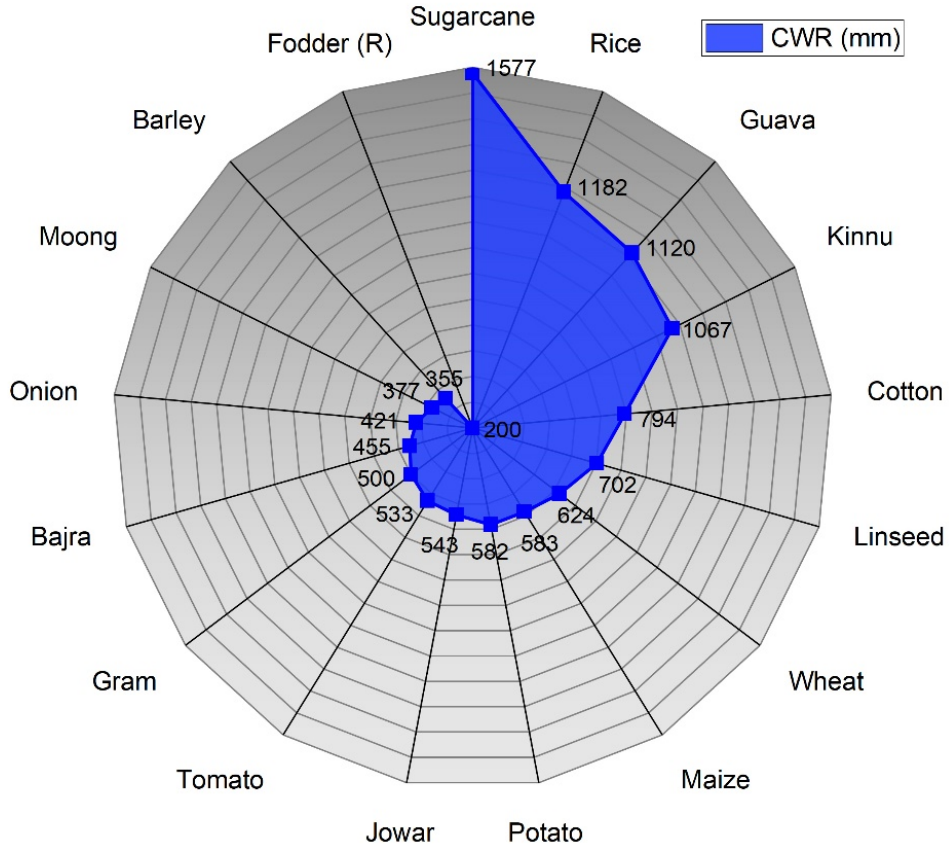
Figure 6. Crop water requirement for all crops grown in LCC area.